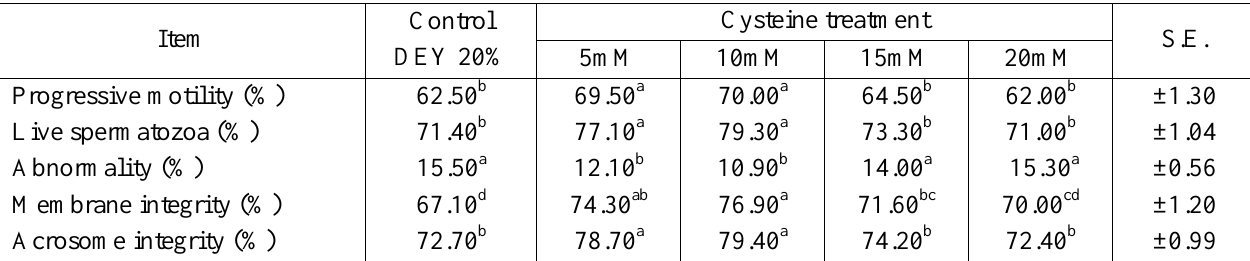
Table 2: Effect of different concentrations of Cysteine added to Holstein bull spermatozoa’s extender, after equilibration at 5 0 C (Mean ± S.E):